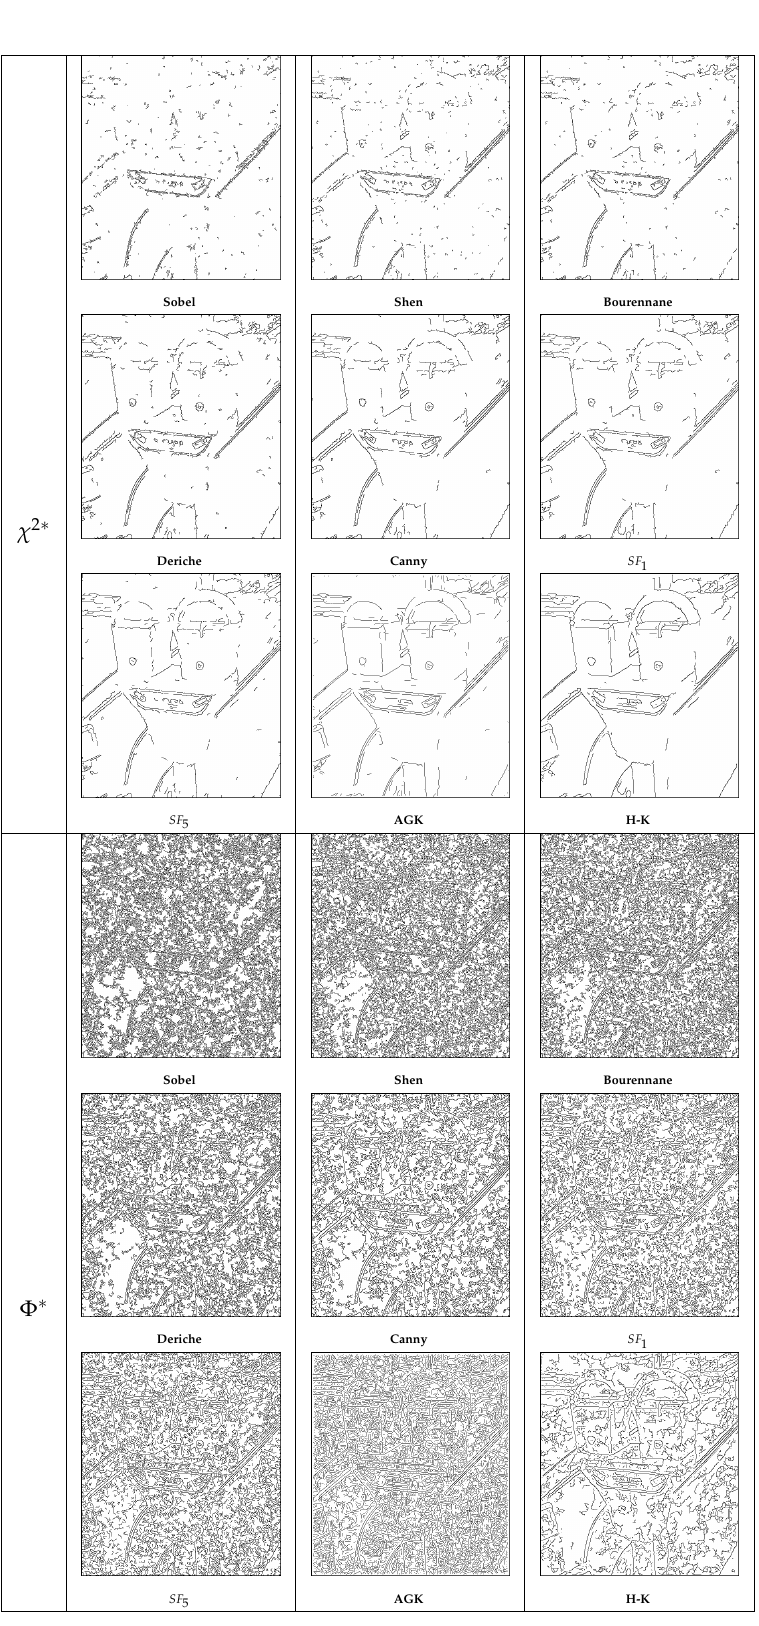
Figure 36. Ideal segmentations for several edge detectors on image parkingmeter, PSNR = 14